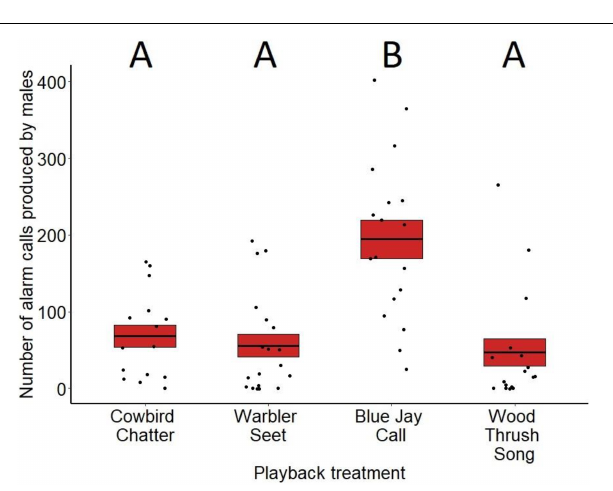
FIGURE 2 | Latency (in seconds) for female red-winged blackbirds to respond to the playback treatments at nests during nestling stage. Means are shown with the bold line, and shaded boxes represent standard errors. Boxes with different letters denote post hoc statistical differences between treatments. For the p -values of post hoc comparisons, please refer to Supplementary Table 1 .